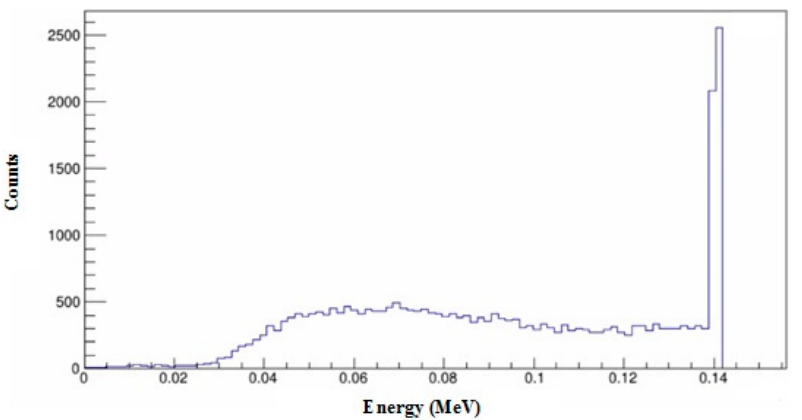
Figure 12. Gamma spectrum for 99m Tc detected from output GATE MC simulation root file, using ROOT software.